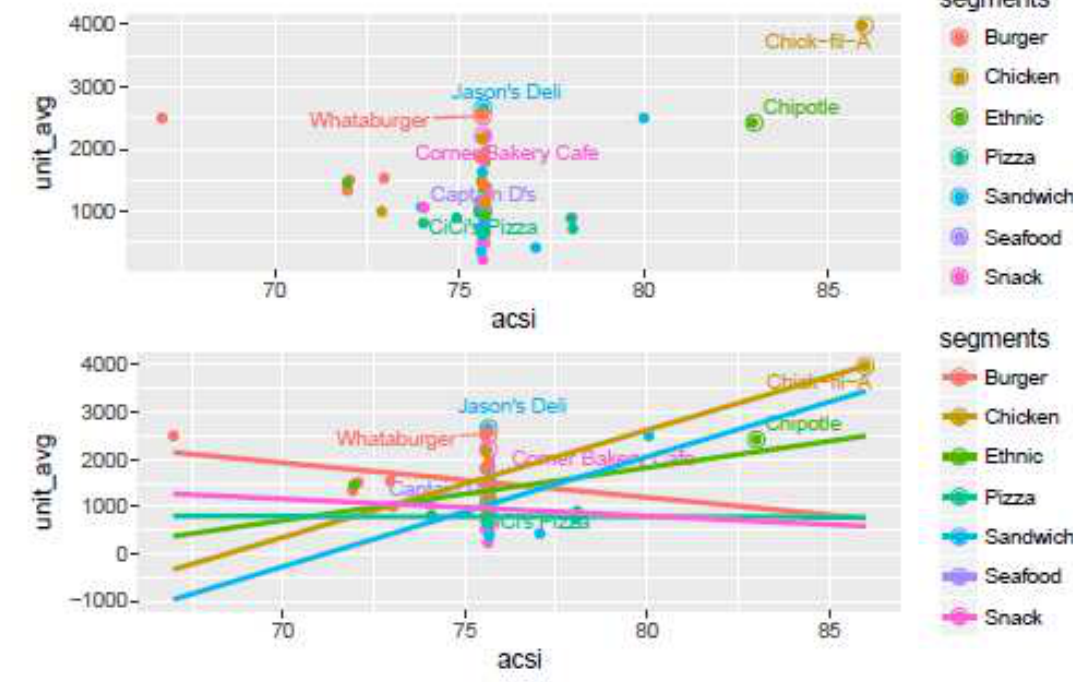
Fig. 6. QSR best-in-segment unit average sales and by segment